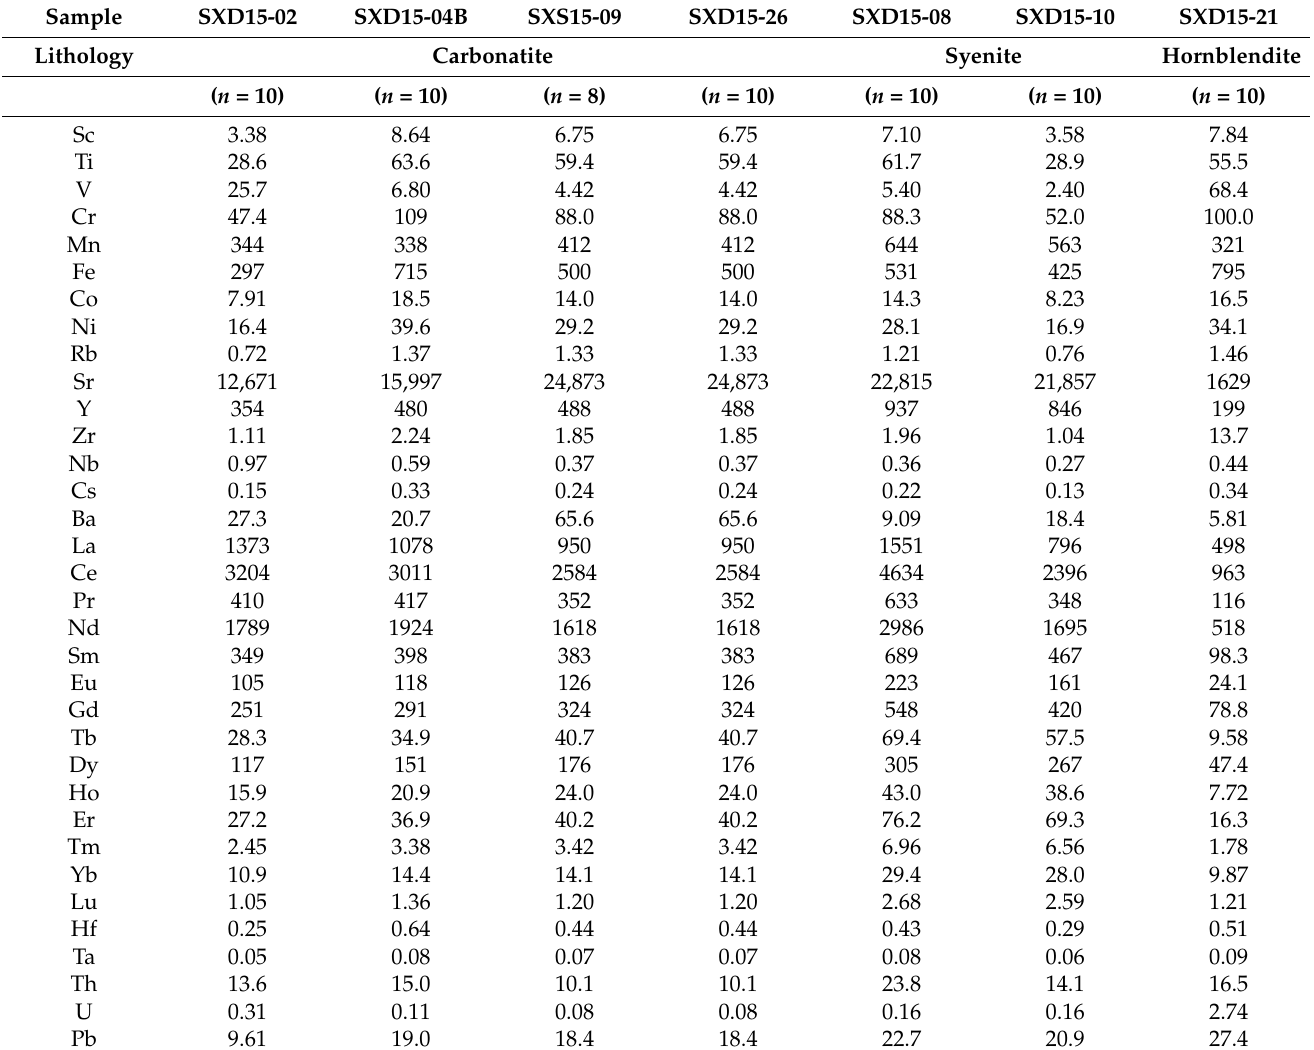
Table 2. Average apatite trace element concentrations obtained by